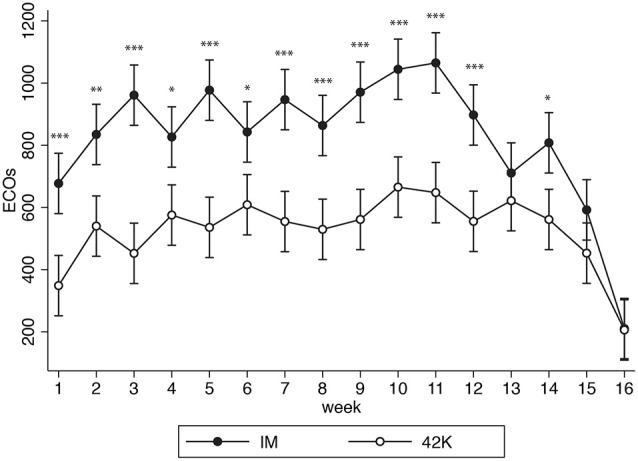
Comparison of IM (black) and 42k (white) weekly training loads (ECOs) during 16 weeks. *p < 0.05; **p < 0.01; ***p < 0.001.